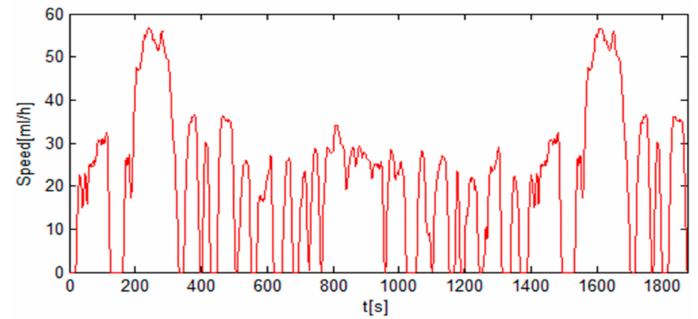
Figure 14. Federal Test Procedure (FTP-75) driving